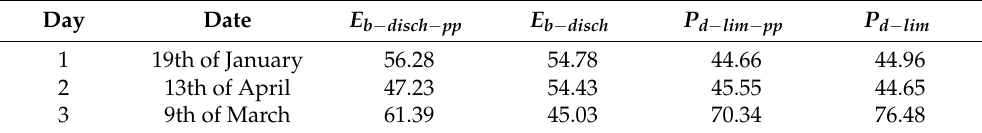
Table 10. Energy available to be discharged from the battery using predicted data ( E b − disch ) and using perfect prediction ( E b − disch − pp ), and P d − lim based on E b − disch as well as P d − lim − pp based on E b − disch − pp